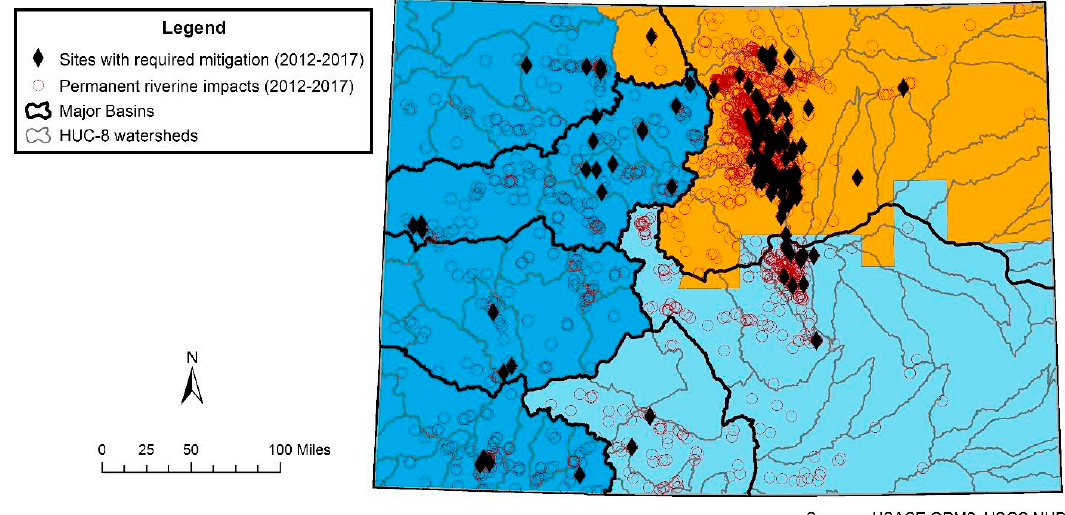
Figure 2. Permanent riverine impacts and sites with required compensatory mitigation in Colorado for 2012–2017. The Colorado USACE districts are NWO (orange), SPK (dark blue), and SPA (light blue).